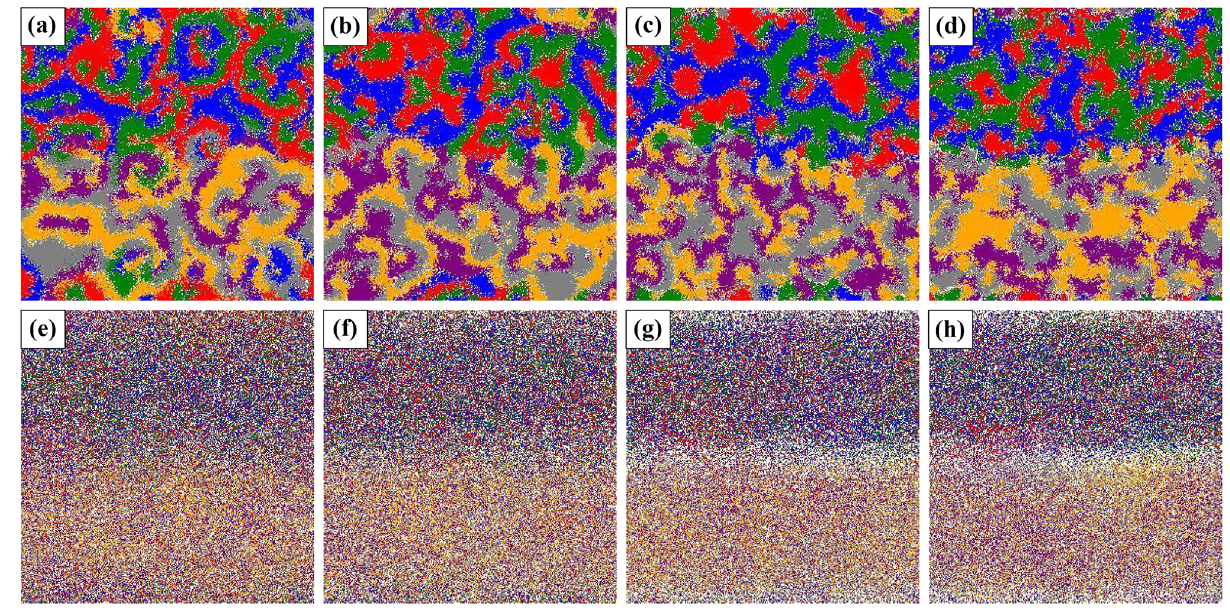
Figure 4. The typical snapshots of evolution on patterns at t = 1000 for different k : 0.5 for ( a ) and ( e ), 2 for ( b ) and ( f ), 10 for ( c ) and ( g ), and 20 for ( d ) and ( h ), where the mobility is considered as M = 1 × 10 − 5 for tops and M = 1 × 10 − 3 for bottoms. Different colors correspond to different species types, as shown in Figs. 1 and 2, with white indicating vacancy. As k increases, the invasion among species between two territories occurs more gradually, and such phenomena are clearly observed for the high mobility as shown in the panel ( h